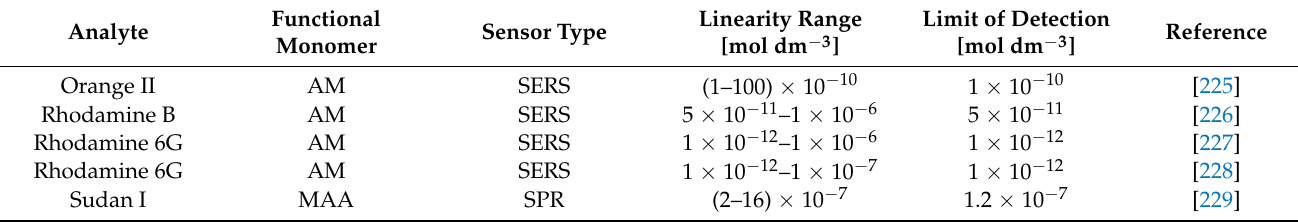
Table 7. MIP plasmonic sensors for dye